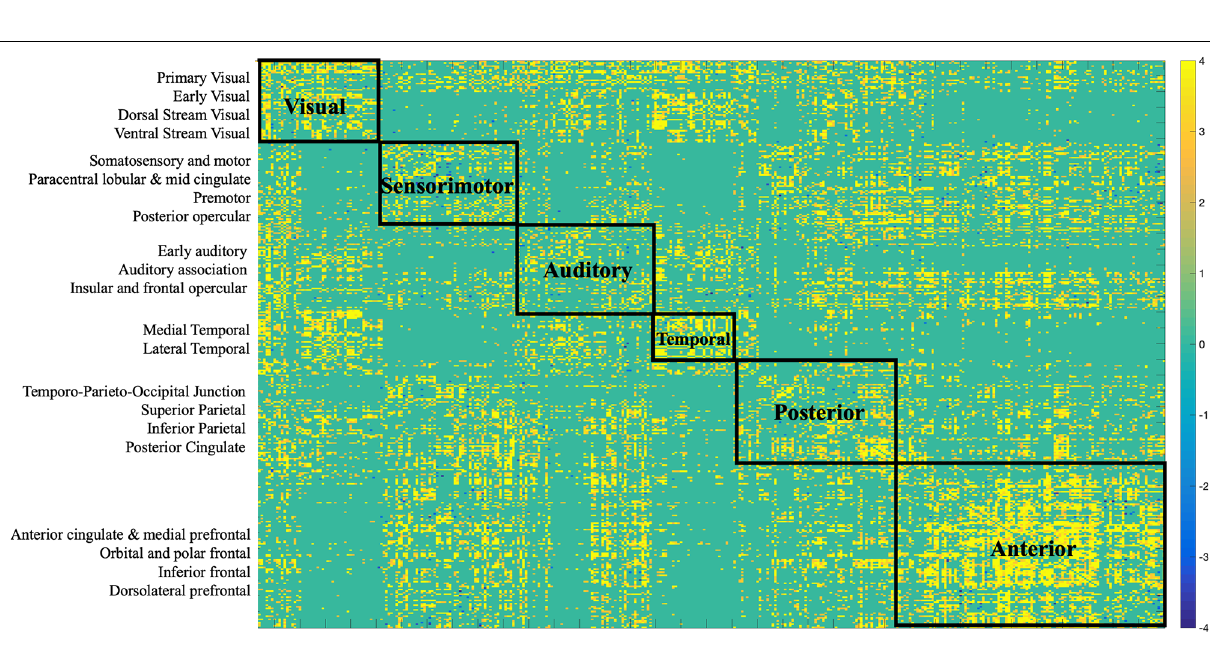
FIGURE 6 | Bootstrap connectivity weights for SC change. Each of the 360 Glasser regions occupies one of the 22 cortices, which are listed on the y-axis. Each cortex was further labeled to a larger partition depicted on the matrix. The assignment is described in detail in Supplementary Neuroanatomical Results in Glasser et al.